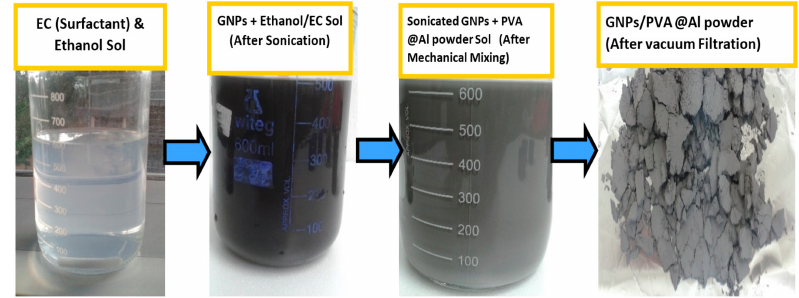
Figure 4. Visual observation of the solutions after the respective processing steps of GNPs incorporation PVA @ Al powder via mechanical